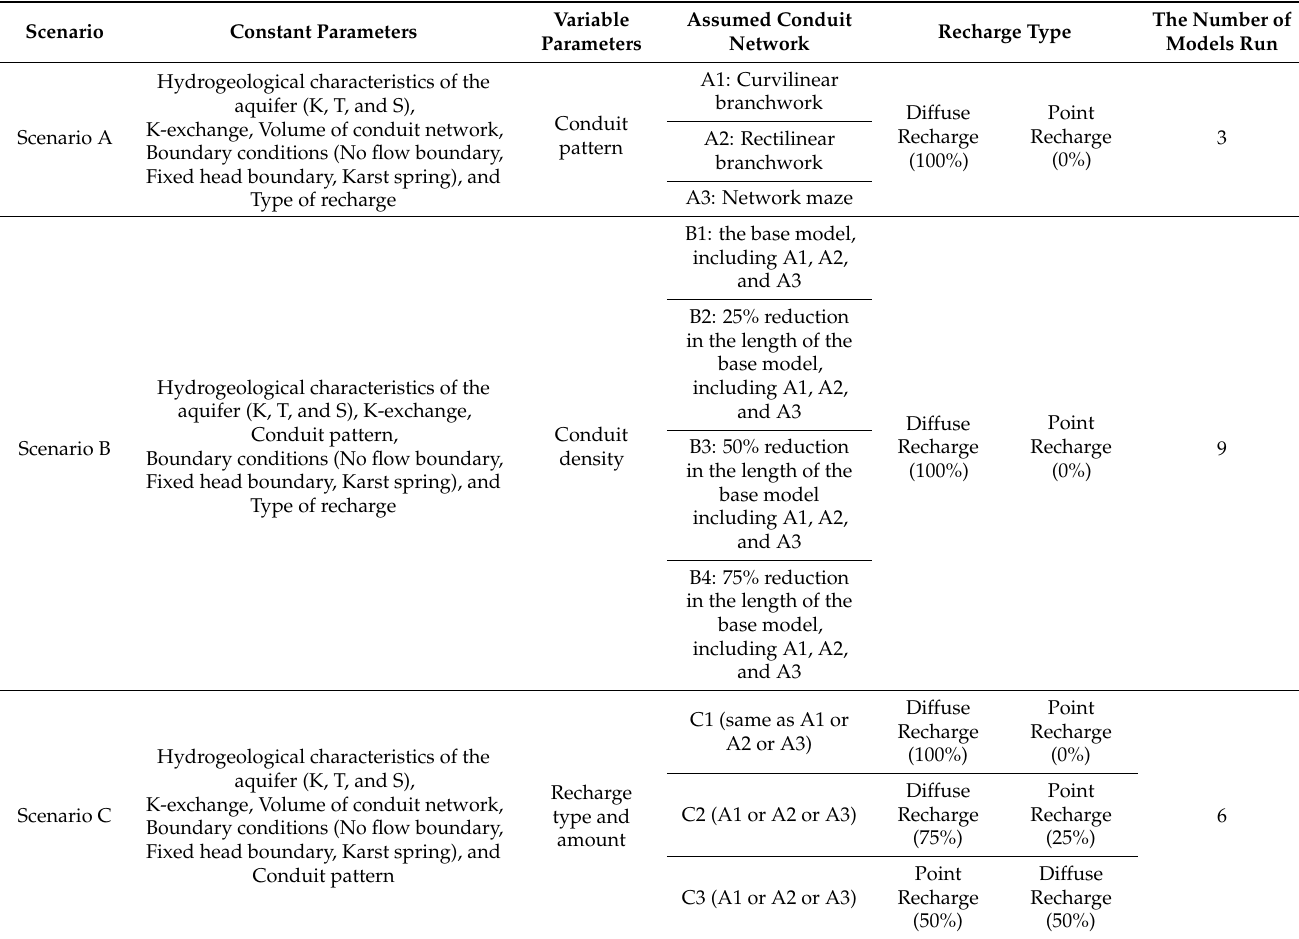
Table 2. Description of the assumed